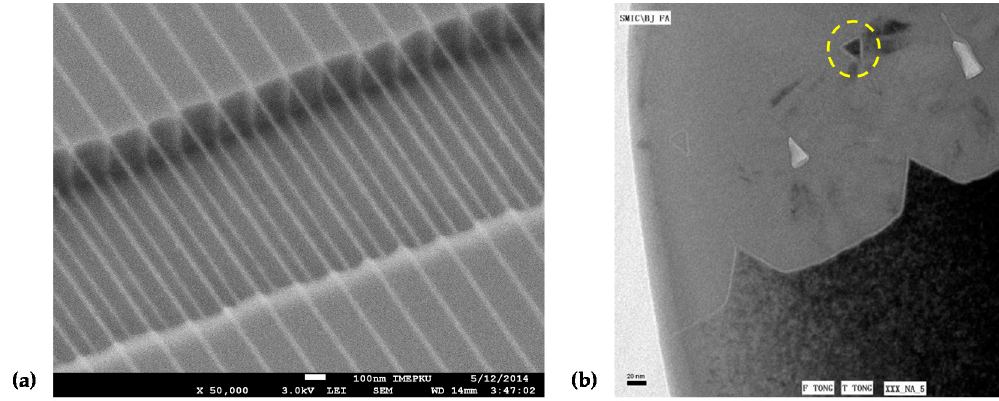
Figure 8. ( a ) SEM image of multiple suspended silicon nanowires formed by TMAH etching; ( b ) TEM image of silicon nanowires after gate oxidation and polysilicon gate deposition.